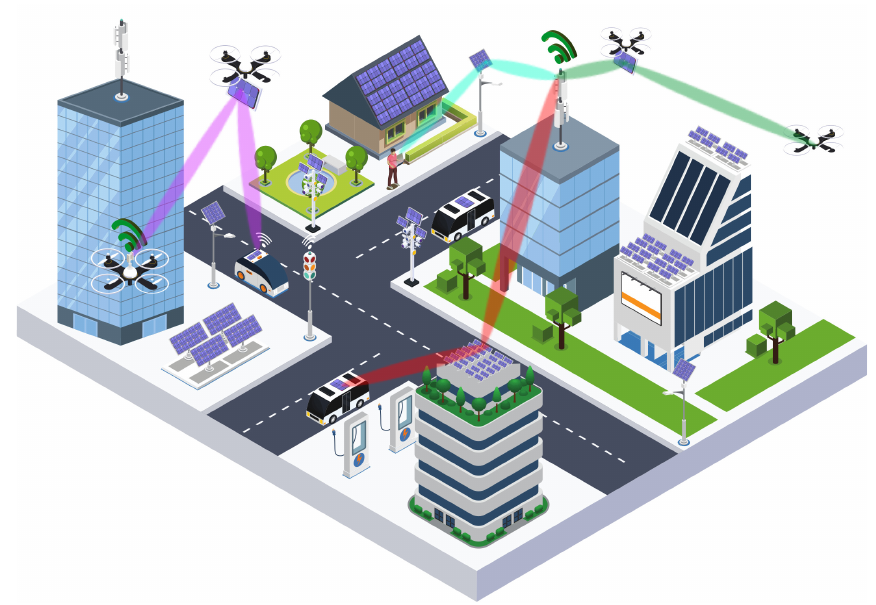
Figure 1. A terrestrial communications system with UAV-mounted